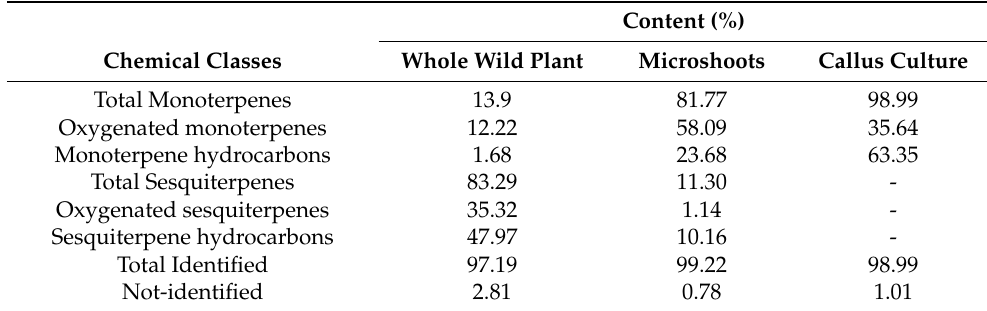
Table 3. Classification and content (%) of VOCs identified by GC-MS analysis in different extracts of C. montanus